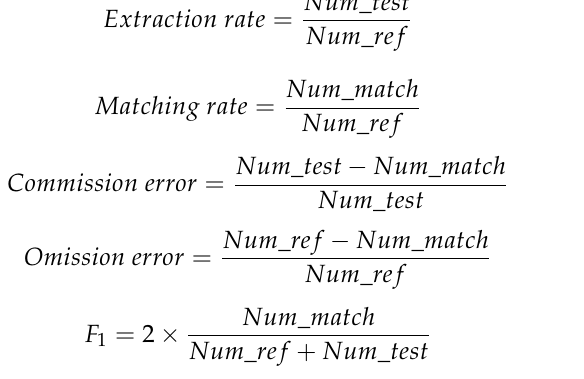
Figure 10. The treetop matching method. The treetops within a radius of the reference tree tops were judged as the candidates. Voting candidates with the height difference and 2D distance between the candidates and the reference tree tops. If a candidate tree top showed a better height difference and its 2D distance difference from the nearest candidate was less than 2.5 m, it was determined as the matching tree top. The numbers above the points indicate the elevation values.